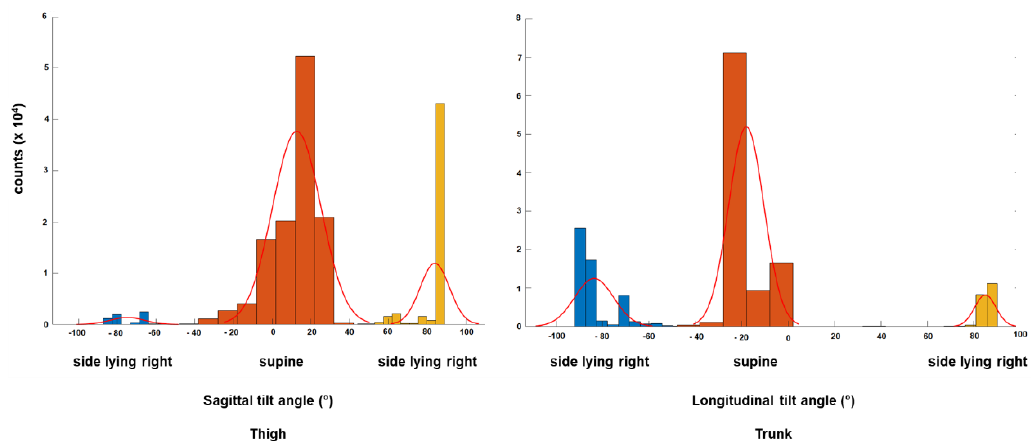
Figure 4. Distribution of tilt angles in a single axis for thigh and trunk sensors during a 5 h pilot recording . The authors’ pilot recoding shows trimodal distribution of sagittal (thigh sensor) and longitudinal (trunk sensor) tilt angles from −90° to +90° to detect position changes. An absolute angle of equal to or greater than ±45 degrees separates the three distributions and is therefore suitable to detect the three major postural transitions over the 180-degree range of side-lying right, supine and side-lying left.